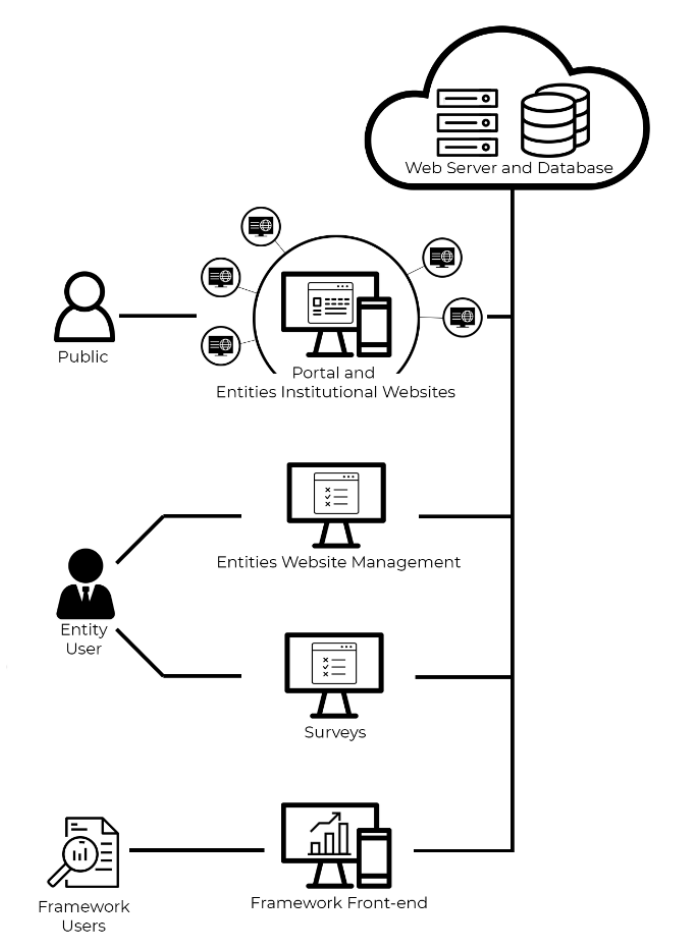
Figure 1. Functional architecture of the solution proposal (Marques, Santos and Duarte,